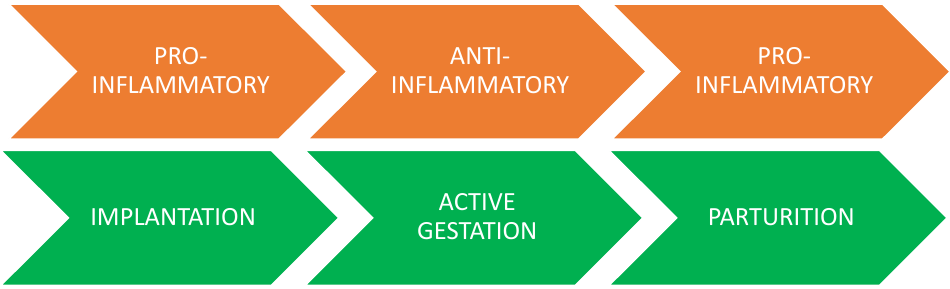
Figure 5. Timeline of pregnancy steps and the pro-inflammatory and anti-inflammatory physiological conditions of the microenvironment generated by the activity of immune cells. Figure generated with PowerPoint.